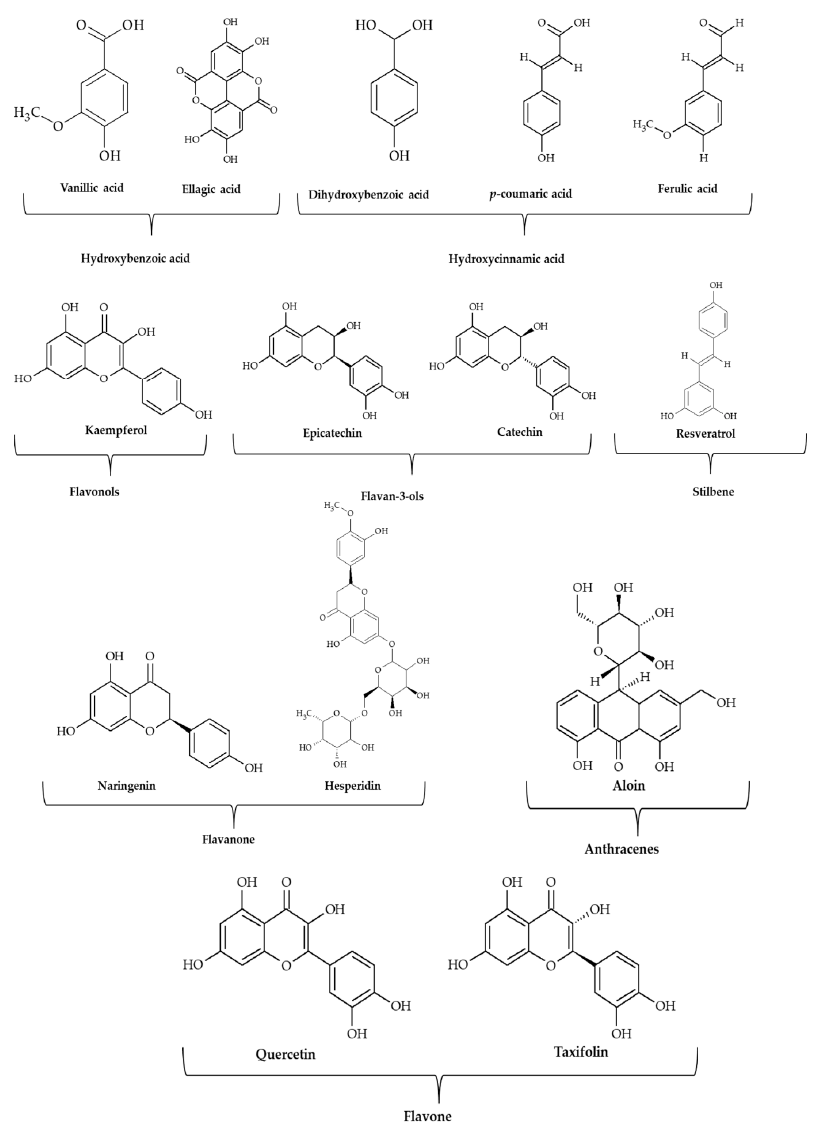
Figure 3. Bioactive compounds identified in Aloe vera juice.